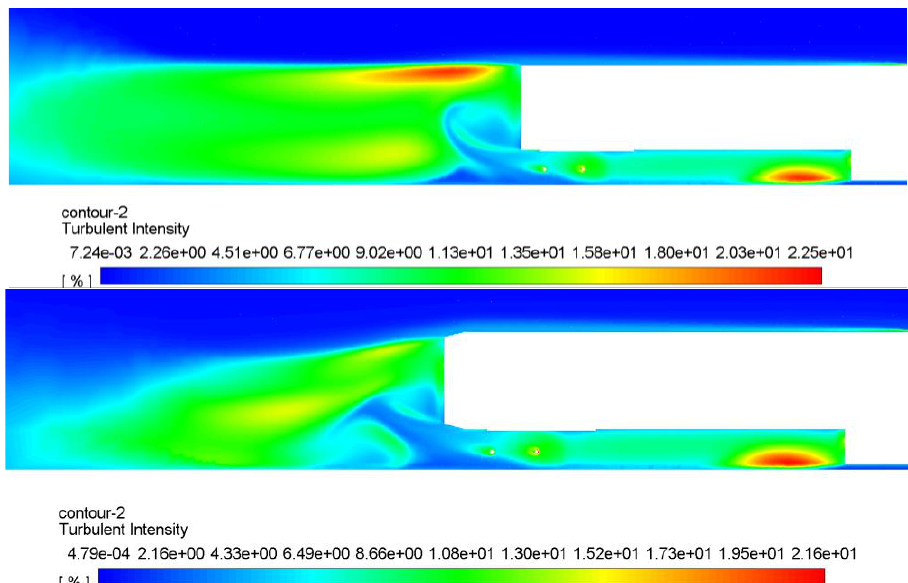
Fig. 16. Side view comparison of the turbulent intensity of the flow between Concept Two – Revision A (top), and Concept Two – Revision B (bottom).